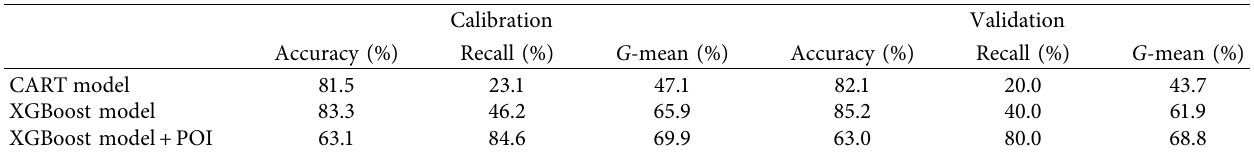
Table 5: Estimation results of the crash severity model.